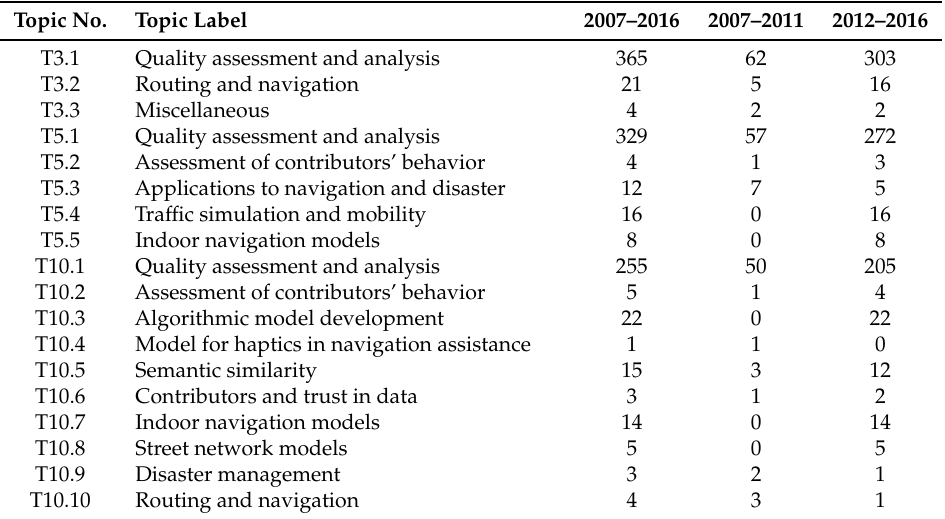
Table 6. Core research areas for